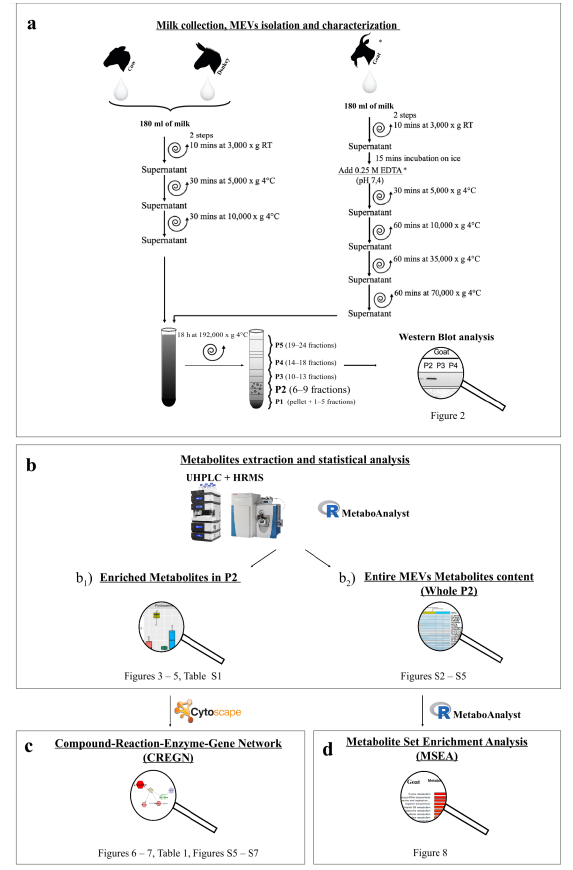
Figure 1. Workflow illustration and related scheme of results placement. ( a ) milk collection, milk extracellular vesicles (MEVs) isolation and characterization; ( b ) Metabolite extraction and statistical analysis; ( b 1 ) differentially abundant metabolites in P2 compared to the other pools; ( b 2 ) total metabolite content of MEVs in whole P2; ( c ) network analysis of enriched MEV metabolites; ( d )